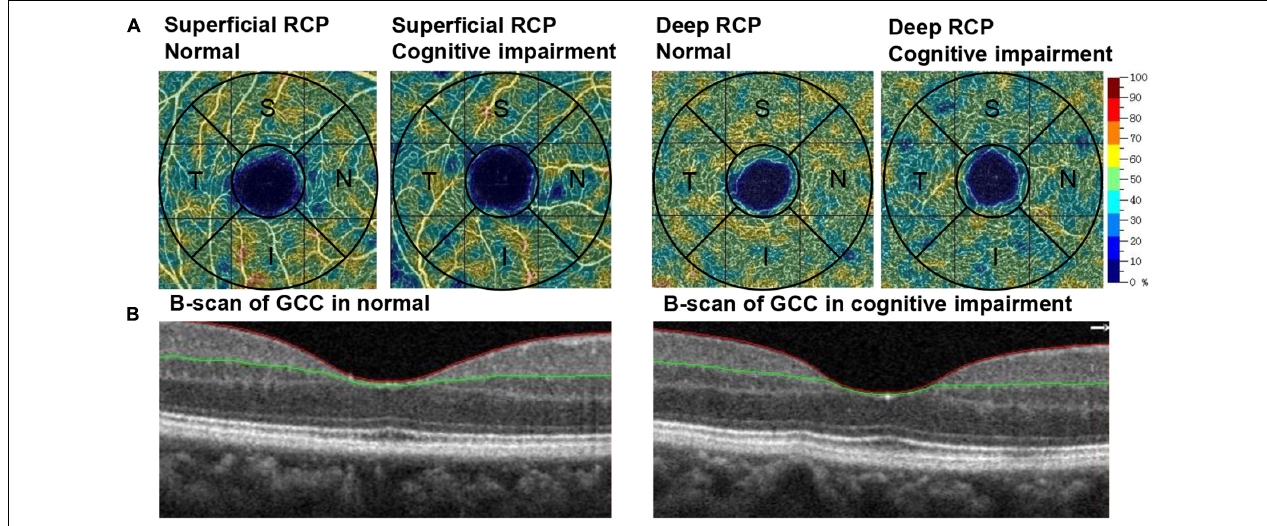
FIGURE 2 | Example of OCTA-generated retinal measurements. (A) The color-coded vessel density maps of superficial RCP and deep RCP in participants with normal cognitive function and cognitive impairment. (B) B-scan of GCC in participants with normal cognitive function and cognitive impairment. RCP, retinal capillary plexus; GCC, ganglion cell complex; OCTA, optical coherence tomography angiography; S, superior; I, inferior; T, temporal; N, nasal.